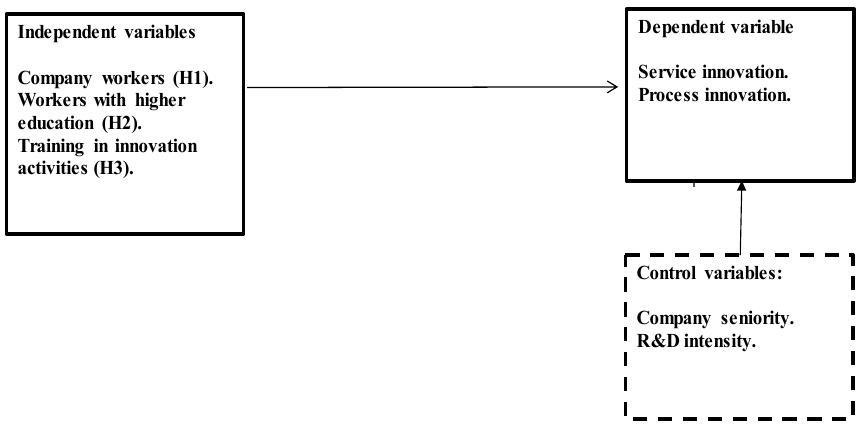
Figure 1. Table of relationship of variables